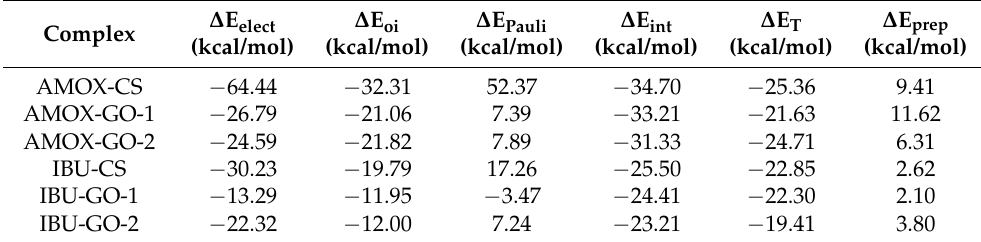
Table 4. Decomposition analysis of total binding energy ( ∆ E T ) for the complexes studies herein.